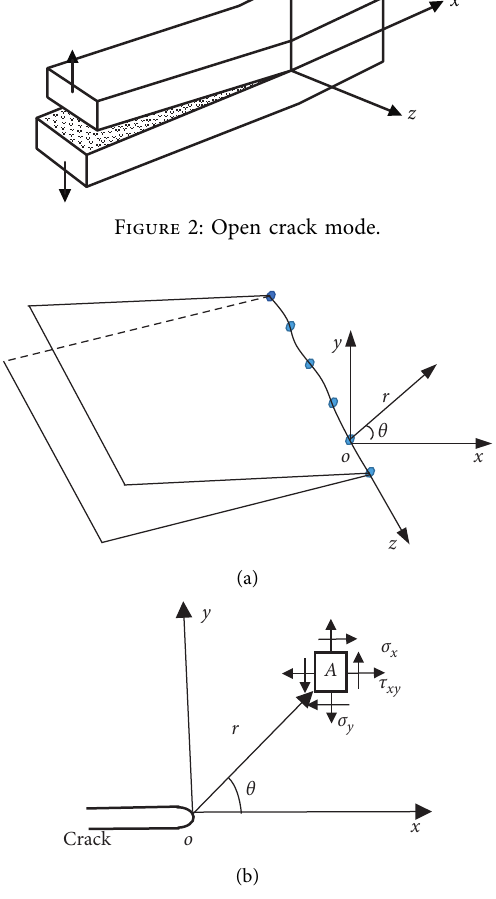
Figure 3: Stress status near the crack tip. (a) Diagram of a three- dimensional crack. (b) Crack coordinate systems.